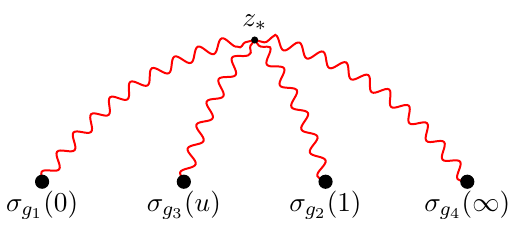
Figure 3 . The choice or the branch cuts in the 4-point